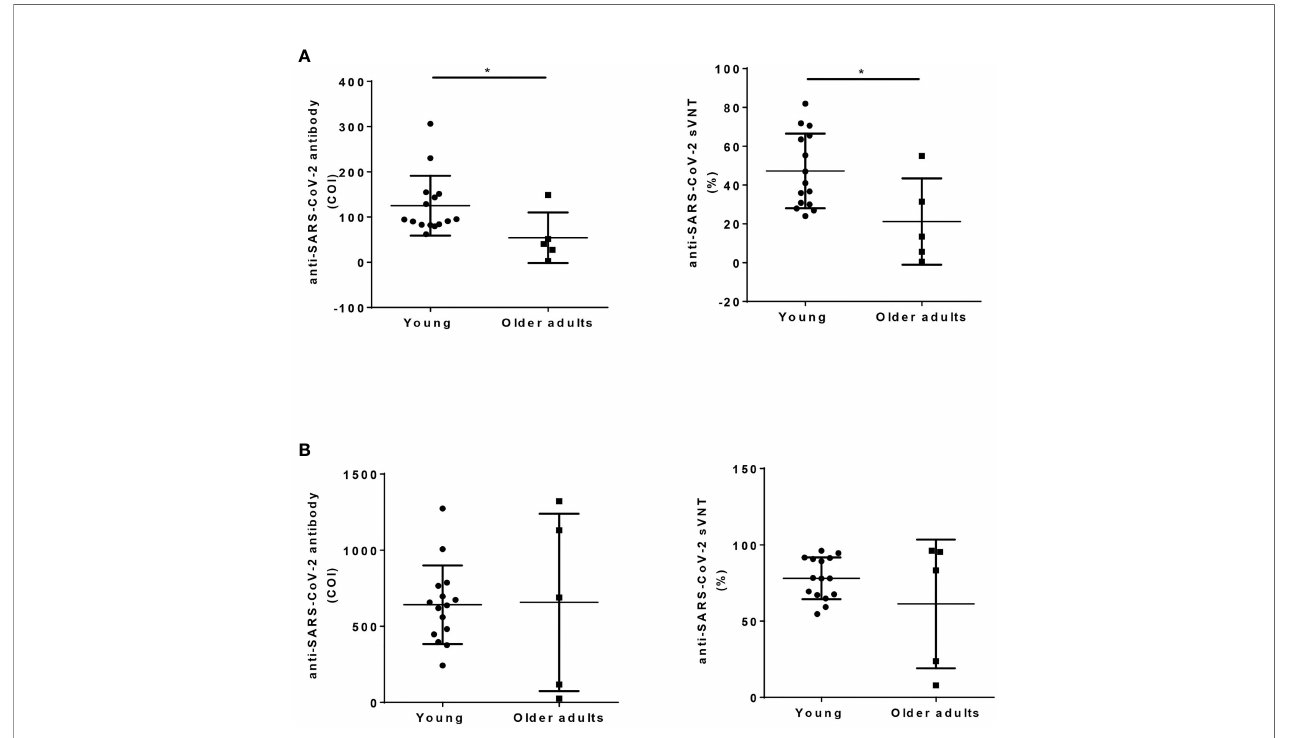
FIGURE 1 | Humoral response after ChAdOx1 nCoV-19 vaccination in young and older adult groups. Anti-SARS-CoV-2 total antibody (left panel, Roche Elecsys), and sVNT (right panel, cPass) were measured using serum collected 2 months after the fi rst dose of vaccination (A) , and 1 month after the 2 nd dose of vaccination (B) in young and older adult groups. Statistical signi fi cance was determined using t-test between 2 groups. (* p value <